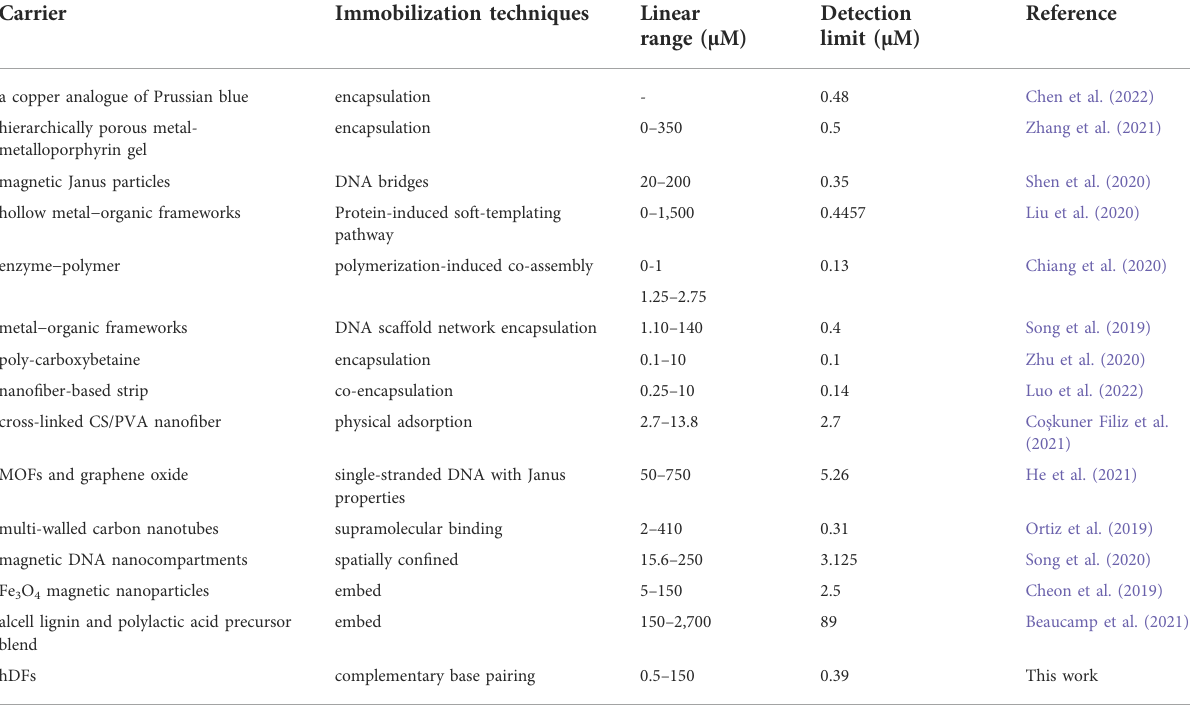
TABLE 2 Comparison of GOx-HRP@hDFs with other peroxidase-mimicking nanozymes for colorimetric detection of glucose.